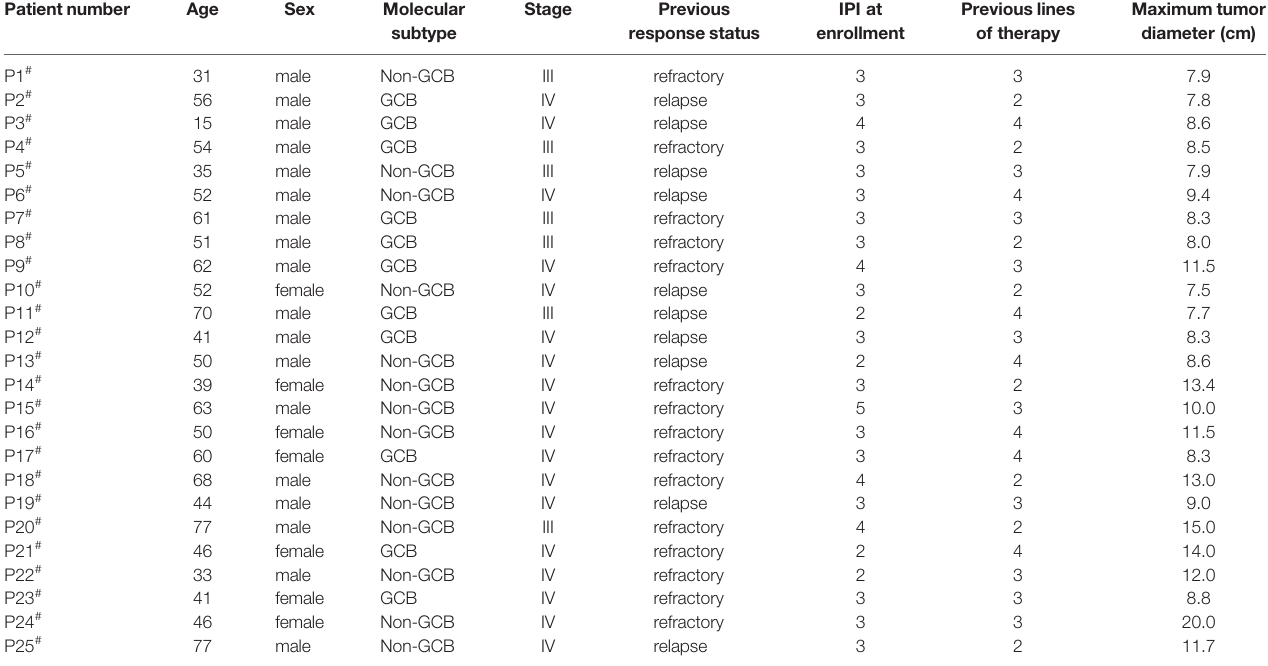
TABLE 1 | Baseline characteristics of patients in the combined group. Patient number Age Sex Molecular